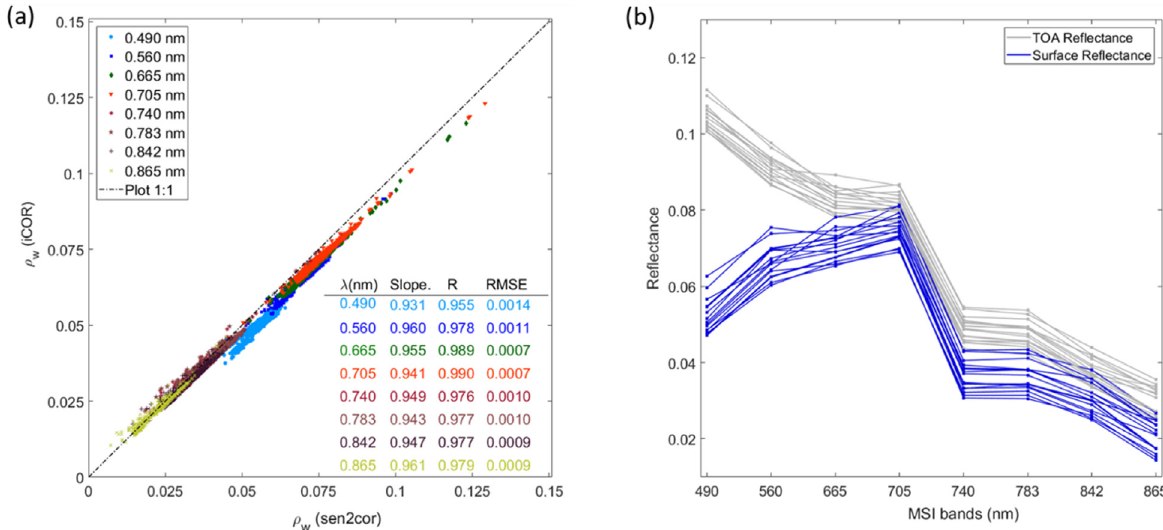
Figure 2. (a) Comparison of surface reflectance (ρw) between Sen2Cor and iCOR products across the lagoon; (b) Comparison between Sen2Cor surface reflectance and Top-of-Atmosphere (TOA)